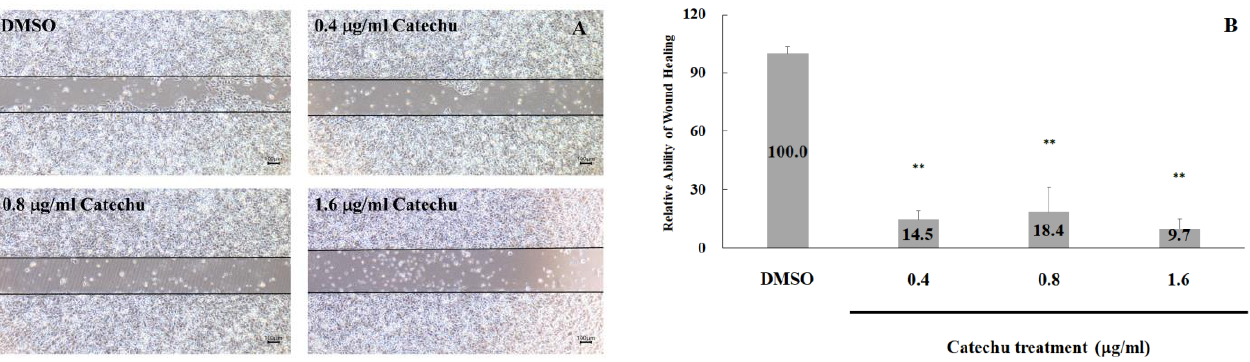
Figure 7. Effects of catechu extracts on wound healing. HaCaT cells were treated with 0.4, 0.8, and 1.6 mg/mL catechu extracts for 48 h. ( A ) The black lines denote the size of the cell-free gap at the beginning of the catechu treatment. HaCaT cells that migrated into the black lines were calculated using ImageJ after 48 h. The quantitation data of wound healing ability are shown in ( B ). Data are presented as means ± SD in three independent experiments. Statistical significance: ** p < 0.005 versus the control group (Con) using the one-tailed test analysis. The DMSO group was the solvent control.